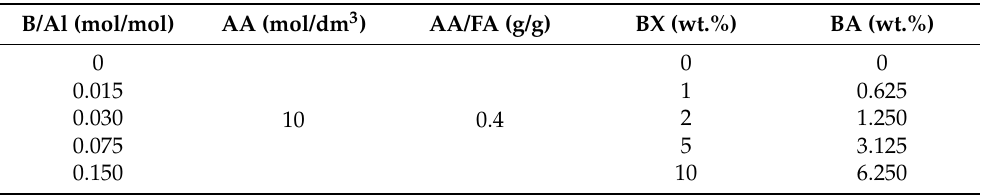
Table 1. Geopolymer composition. AA: alkali activator (NaOH) solution; FA: fly ash; BX: borax; BA: boric acid. B/Al (mol/mol) AA (mol/dm 3 ) AA/FA (g/g) BX